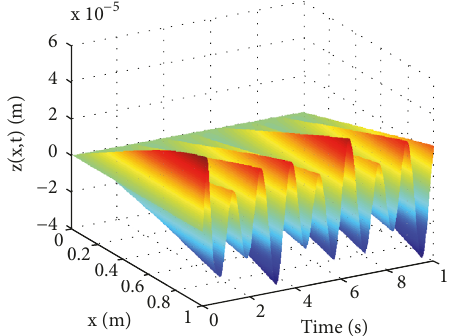
Figure 2: Deflection of the string without control.